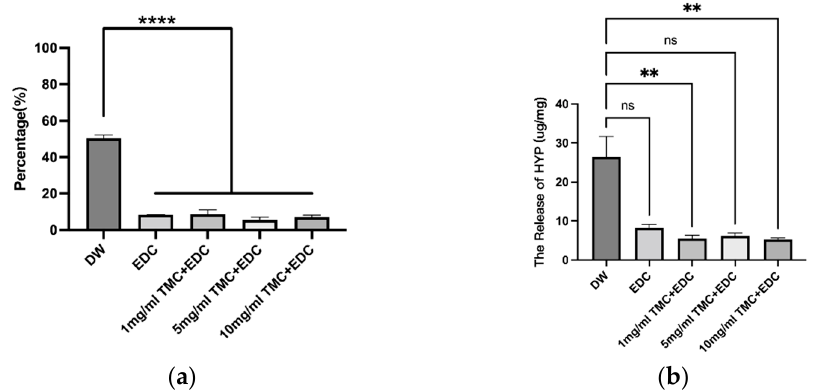
Figure 4. ( a ) The percentage of dry weight loss in each group; ( b ) The release of HYP in each group. (ns, no statistical significance; **, p < 0.01; ****, p < 0.0001).